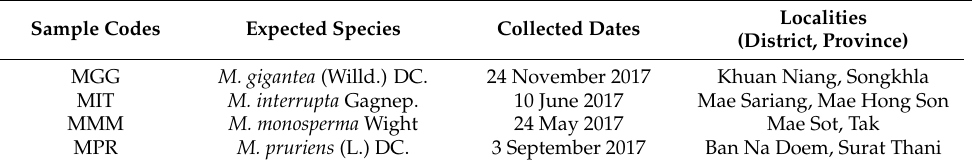
Table 1. The collected Mucuna samples used in this study. Sample Codes Expected